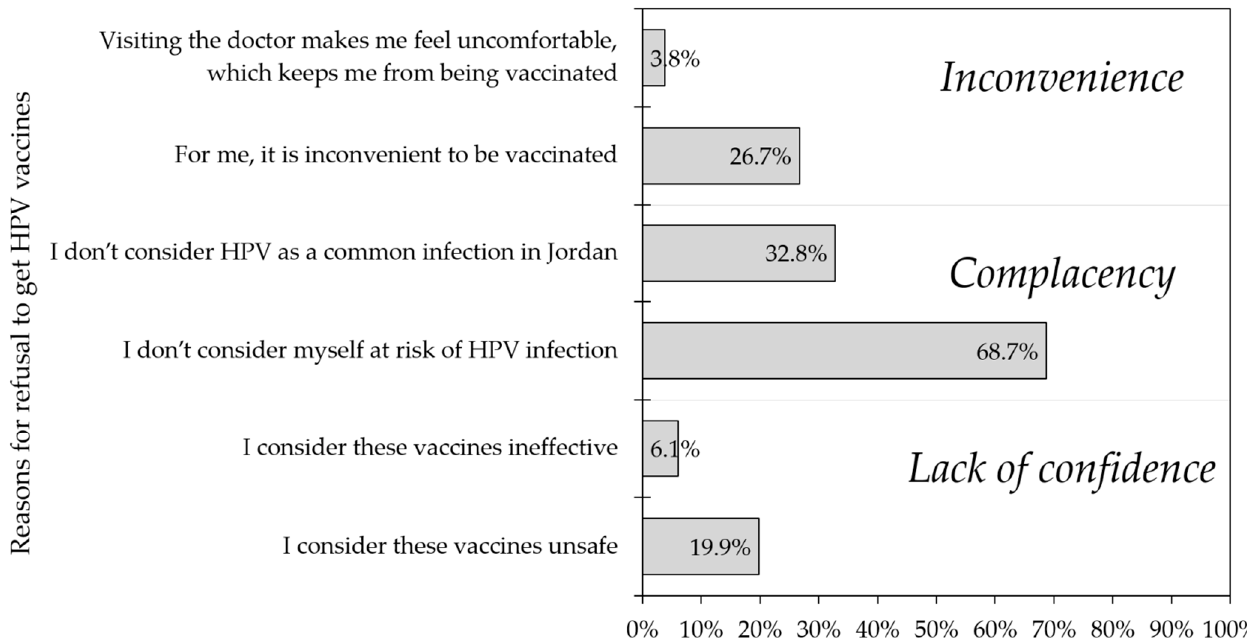
Figure 3. The reasons for refusal to get the human papillomavirus (HPV) vaccination.